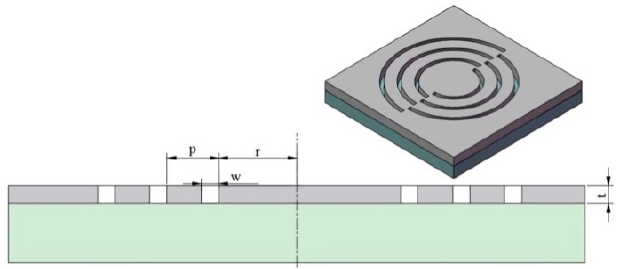
Figure 5. Schematic and parameters of the designed plasmonic lens. Table 1. Optimized structural parameters of the plasmonic